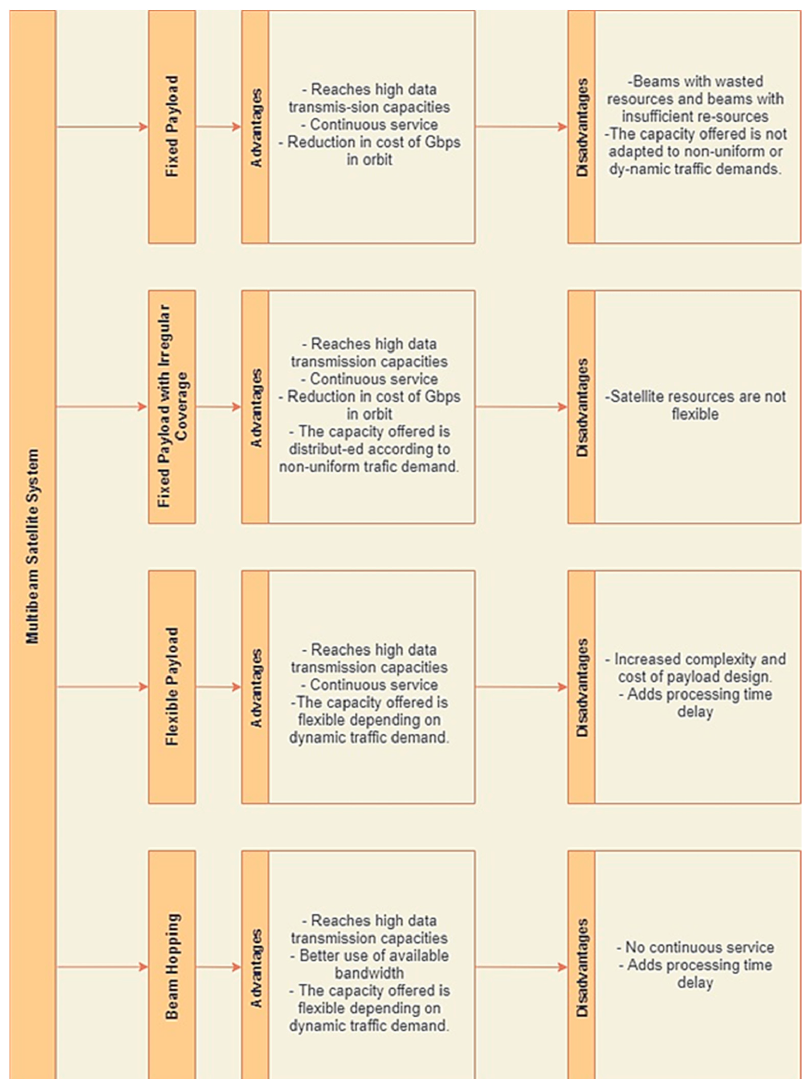
Figure 1. Very High Throughput Satellites (VHTS) multibeam system features.